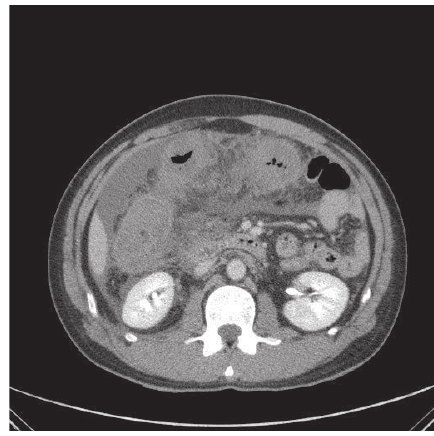
Figure 2: Transverse colon inflammation.